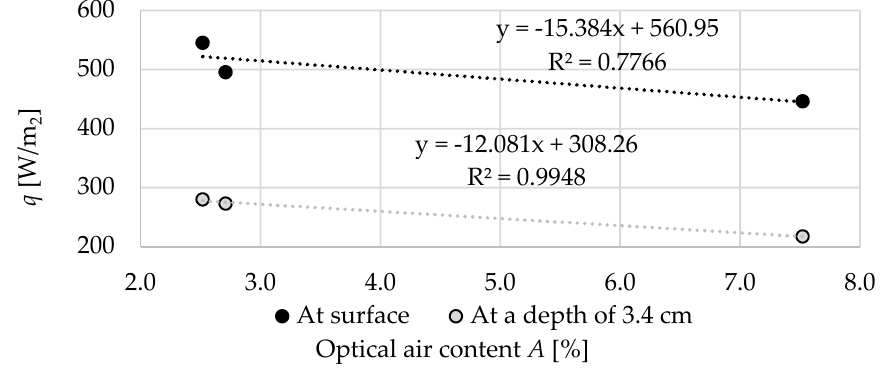
Figure 18. The relation between the optical air content A and maximum heat flux density q.